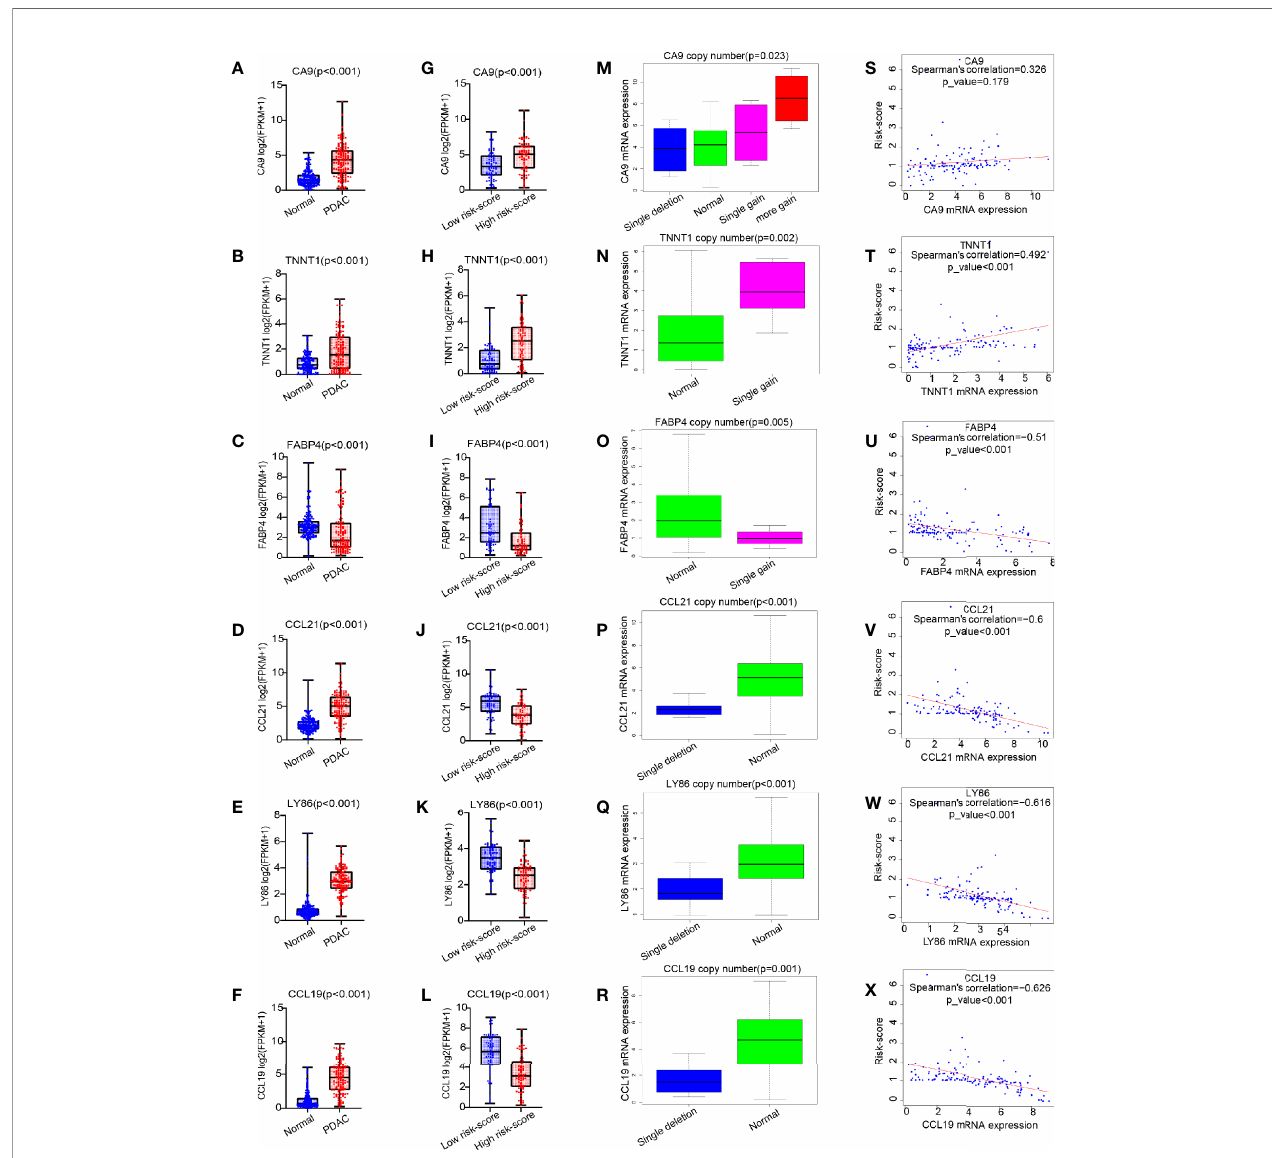
FIGURE 6 | The expression pattern of six common genes and their correlation with risk score. (A – L) Box plot for analysis of six genes (CA9, TNNT1, FABP4, CCL21, LY86, and CCL19) expression difference in normal (TCGA + GTEx) vs . PDAC (TCGA), and high risk score vs . low risk score. (M – R) Box plot for analysis of the relationship between six gene expression (CA9, TNNT1, FABP4, CCL21, LY86, and CCL19) and CNV. (S – X) Correlation of six gene expression (CA9, TNNT1, FABP4, CCL21, LY86, and CCL19) with risk score. TCGA, The Cancer Genome Atlas; GTEx, Genotype-Tissue Expression; PDAC, pancreatic ductal adenocarcinoma; CNV, copy number